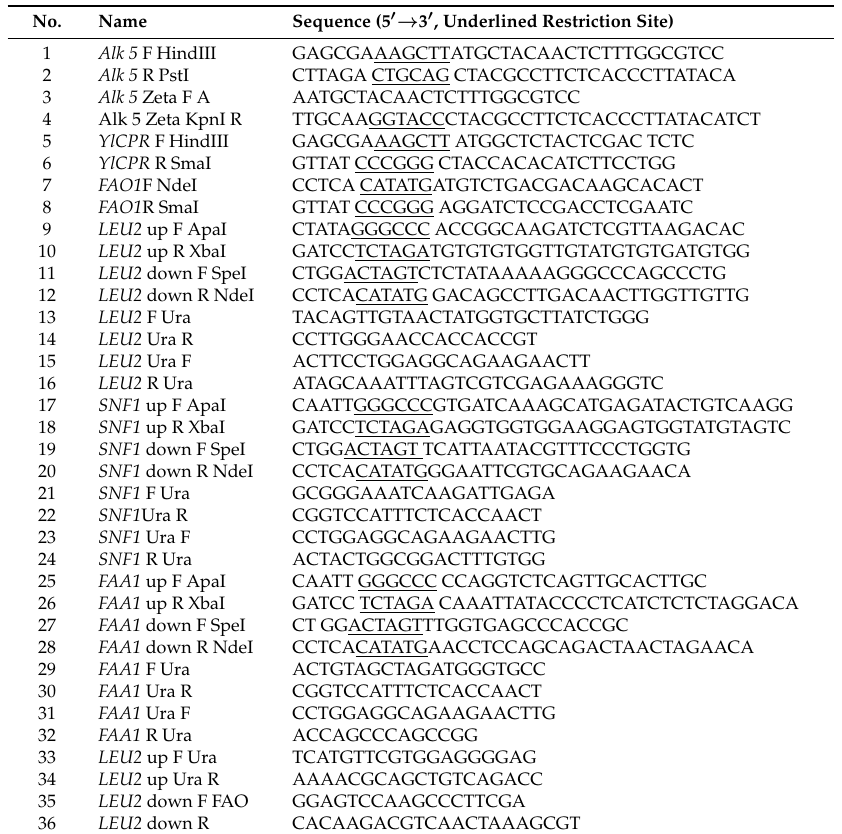
Table 3. PCR primers used in this